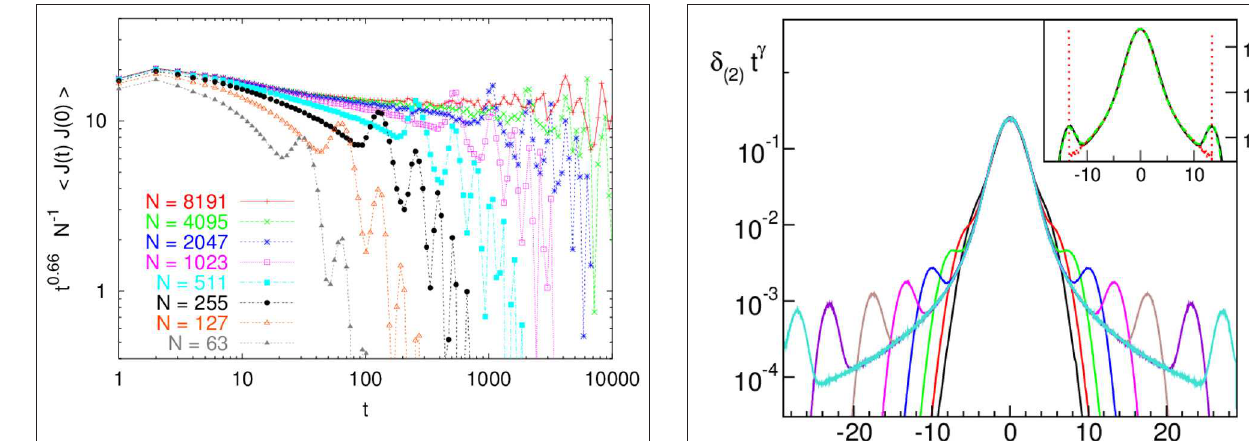
FIGURE 2 | Total scaled heat current auto-correlation, t 0.66 N − 1 alternate mass hard particle gas for mass ratio 2.2 and T Grassberger et al. with permission from [7] Copyright (2002) by American Physical Society).